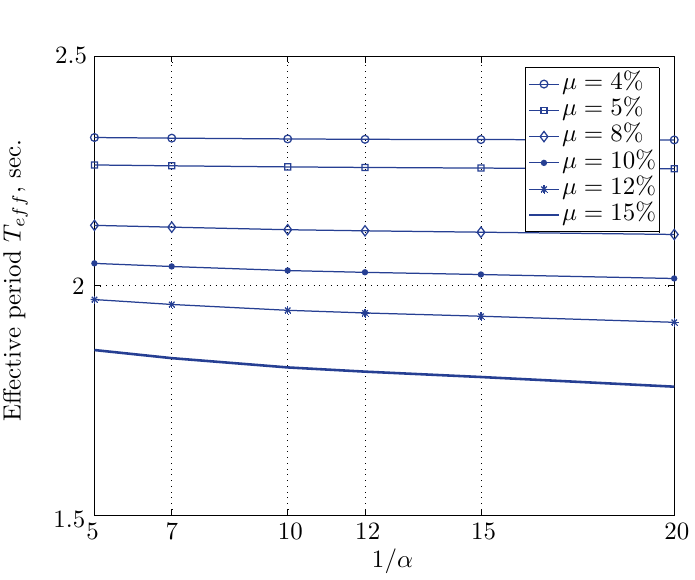
Figure 37. Effective period for various isolation system parameters